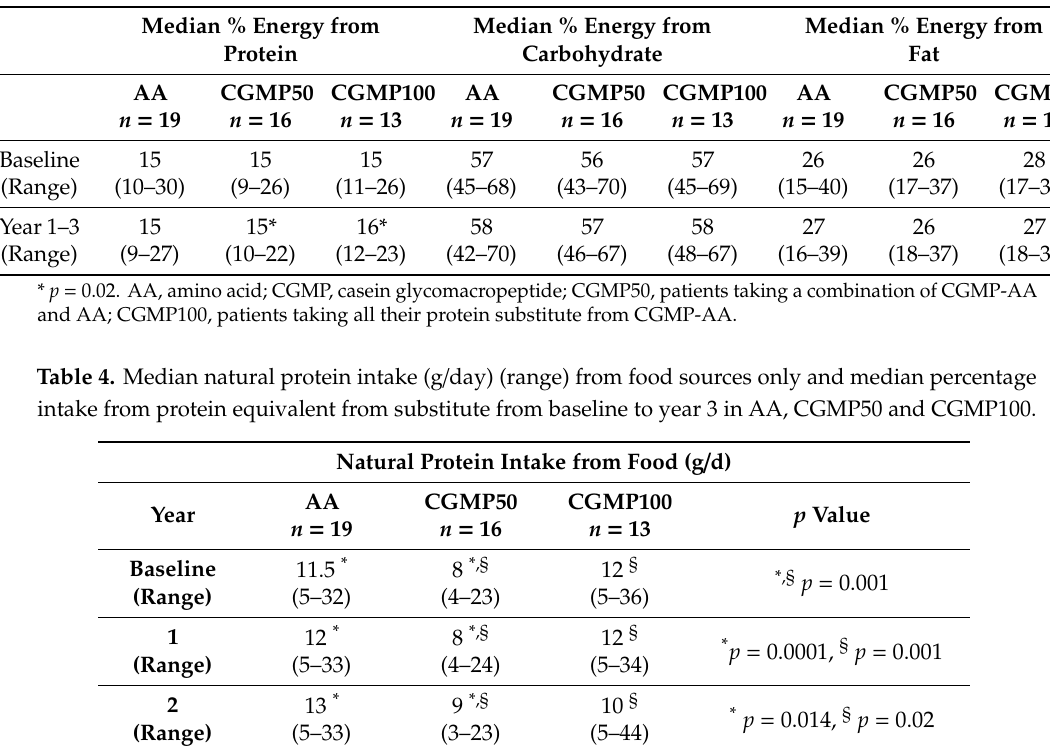
Table 3. Median three-year percentage (range) energy contribution for protein, carbohydrate and fat from food and protein substitute in AA, CGMP50 and CGMP100.